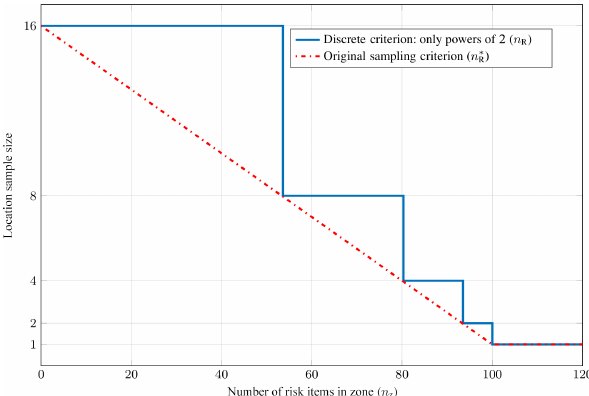
Figure 10. Criterion II.b: maximum number of samples per zone depending on the number of risk items in an administrative zone. The discrete realization of the criterion (limited to powers of 2) is shown in blue, while the red line represents the theoretical linear behavior.